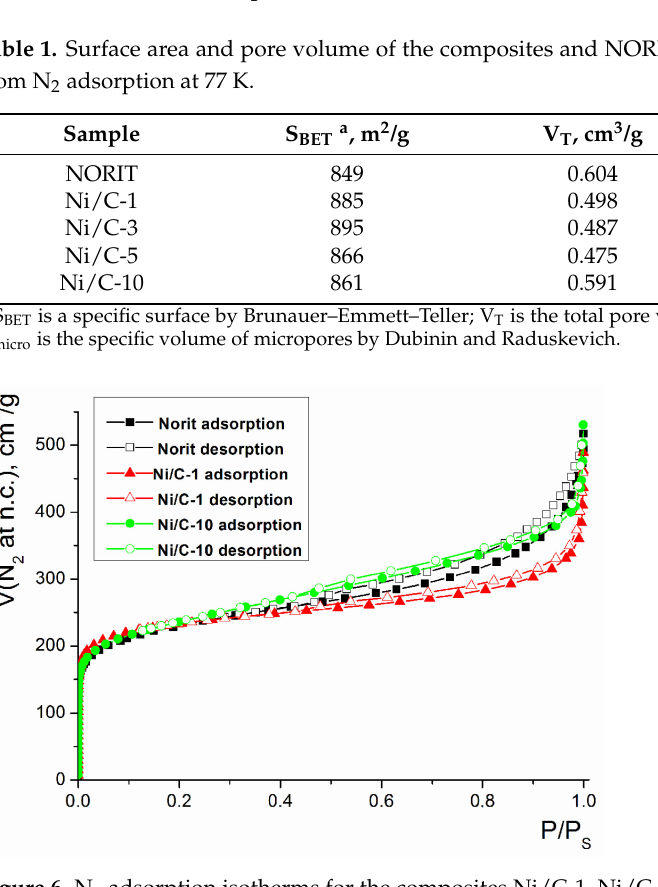
Figure 6. N 2 adsorption isotherms for the composites Ni/C-1, Ni/C-10, and